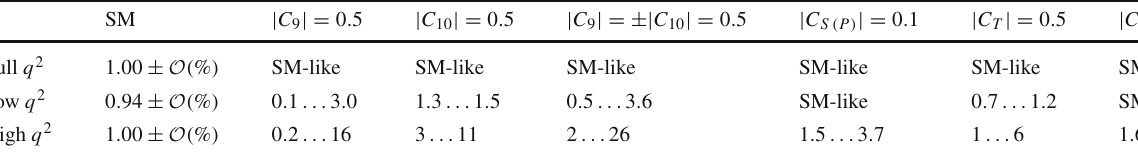
Table 4 R D s (15) in the SM and in NP scenarios for different q 2 –bins, see Table 3 and K